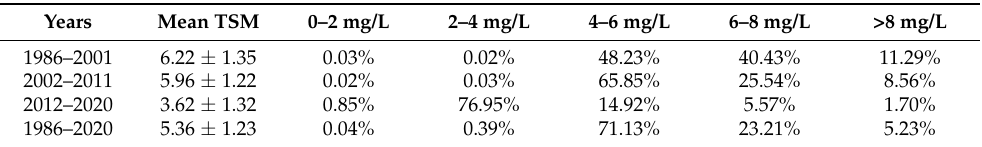
Table 4. The area percentage of different TSM concertation during three periods, including